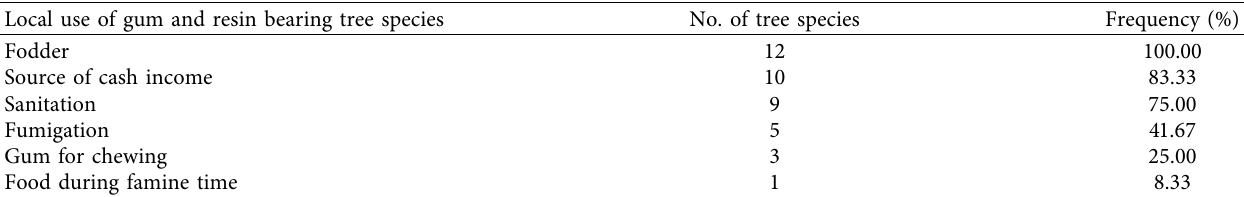
Table 4: Percentage of local use of gum and resin bearing tree species for both districts in South Omo Zone. Local use of gum and resin bearing tree